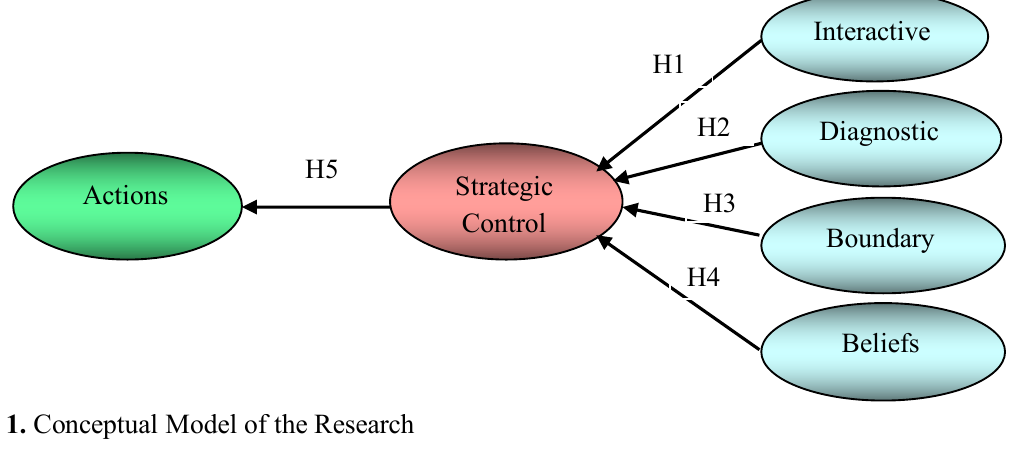
Figure1 . The Research’s Model